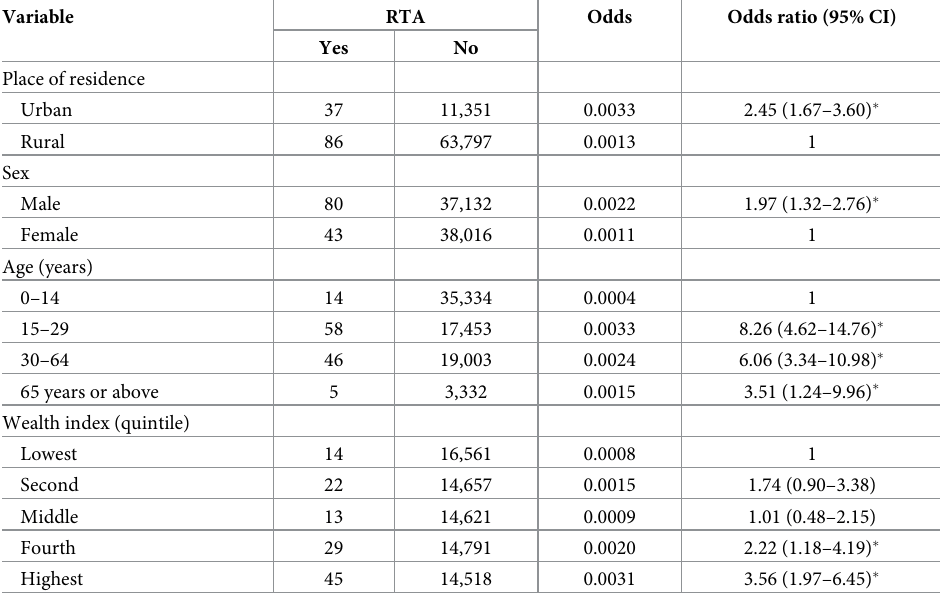
Table 3. Association between selected socio-demographic factors and road traffic accident, Ethiopia,